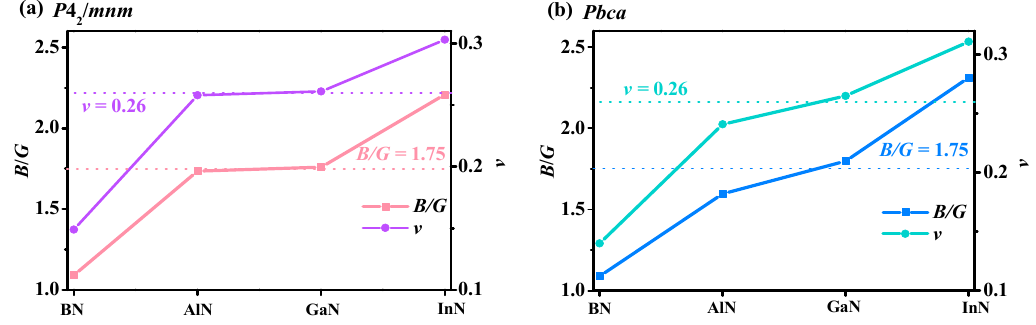
Figure 4. Bulk modulus ( B ) and shear modulus ( G ) ratio ( B / G ) and Poisson’s ratio ( v ) of P 4 2 / mnm XN ( a ), and B / G and v of Pbca XN ( b